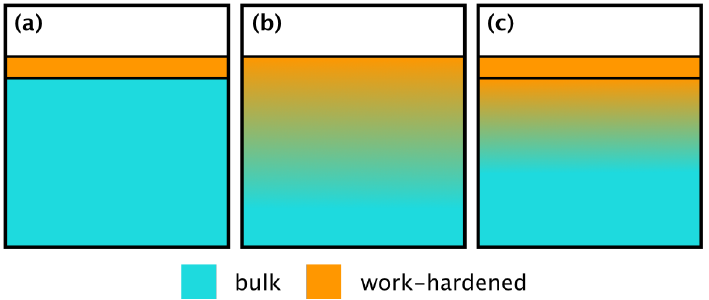
Figure 15. Different interpretations of the indentation results. ( a ) Thin, uniformly hardened film. ( b ) Gradually strain-hardened layer. ( c ) Combination of a gradually strain-hardened layer and a thin